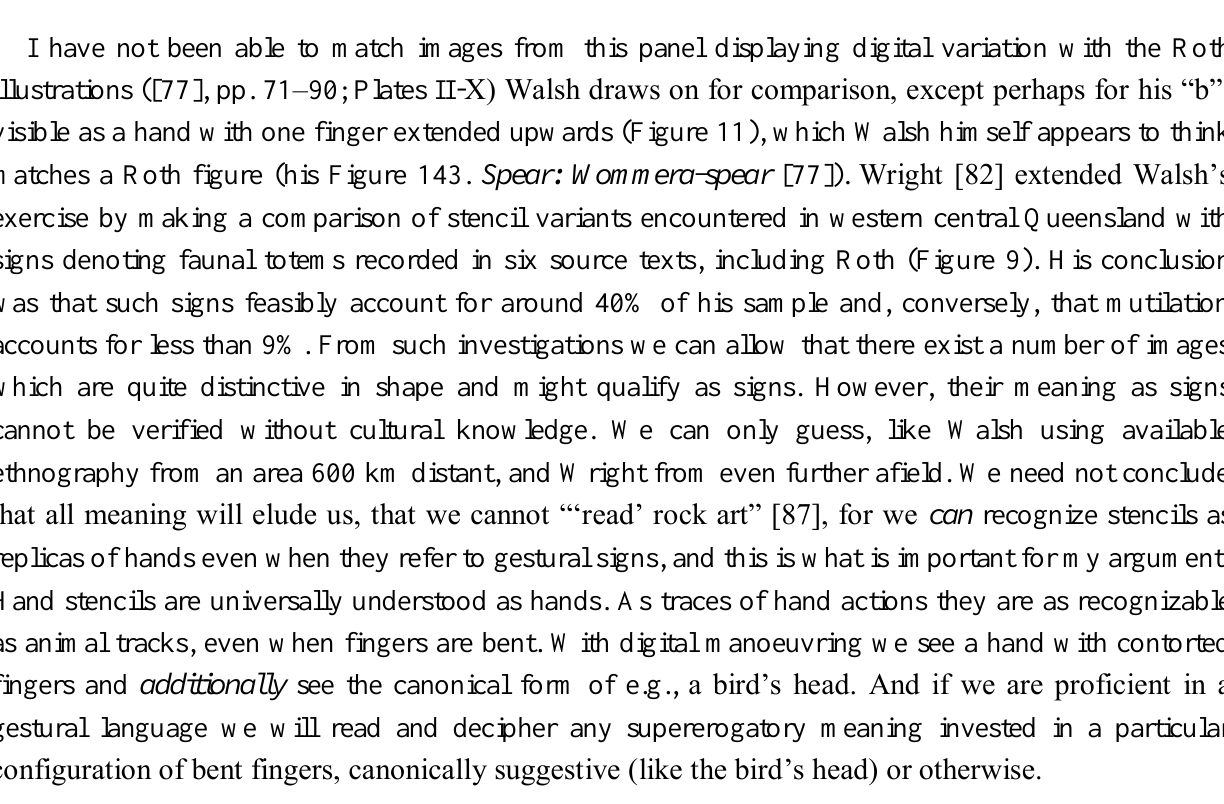
Figure 11. G.L. Walsh, “Mutilated Hands or Signal Stencils?”. Australian Archaeology 1979 , 9 , p. 35. (Example “b” is seen top